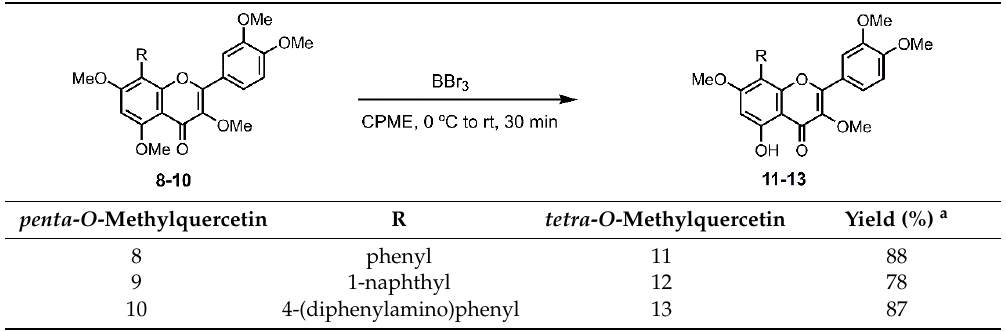
penta - O -Methylquercetin